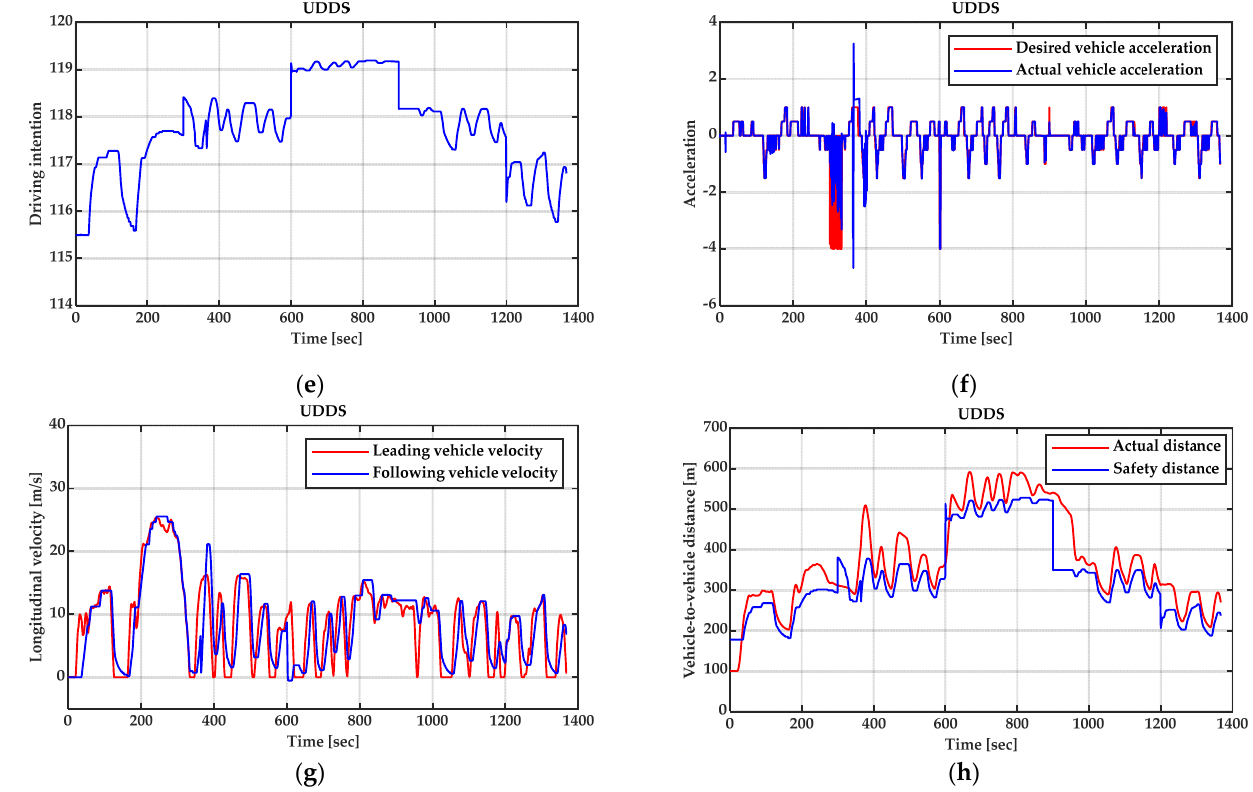
Figure 7. Dry asphal t –snow–ice-mixed road experiments in UDDS with deep neural network. ( a ) Road characteristic parameter of left and right tires. ( b ) Average adhesion coefficient. ( c ) Adhesion coefficients of front tires. ( d ) Adhesion coefficients of rear tires. ( e ) Driving intention. ( f ) Acceleration of following vehicle. ( g ) Longitudinal velocities of leading and following vehicles. ( h ) Vehicle-to-vehicle distance and actual distance.